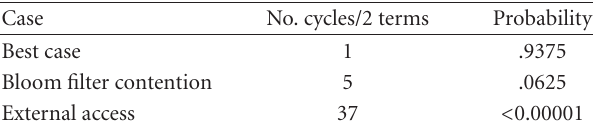
Table 2: FPGA Cycle counts for di ff erent